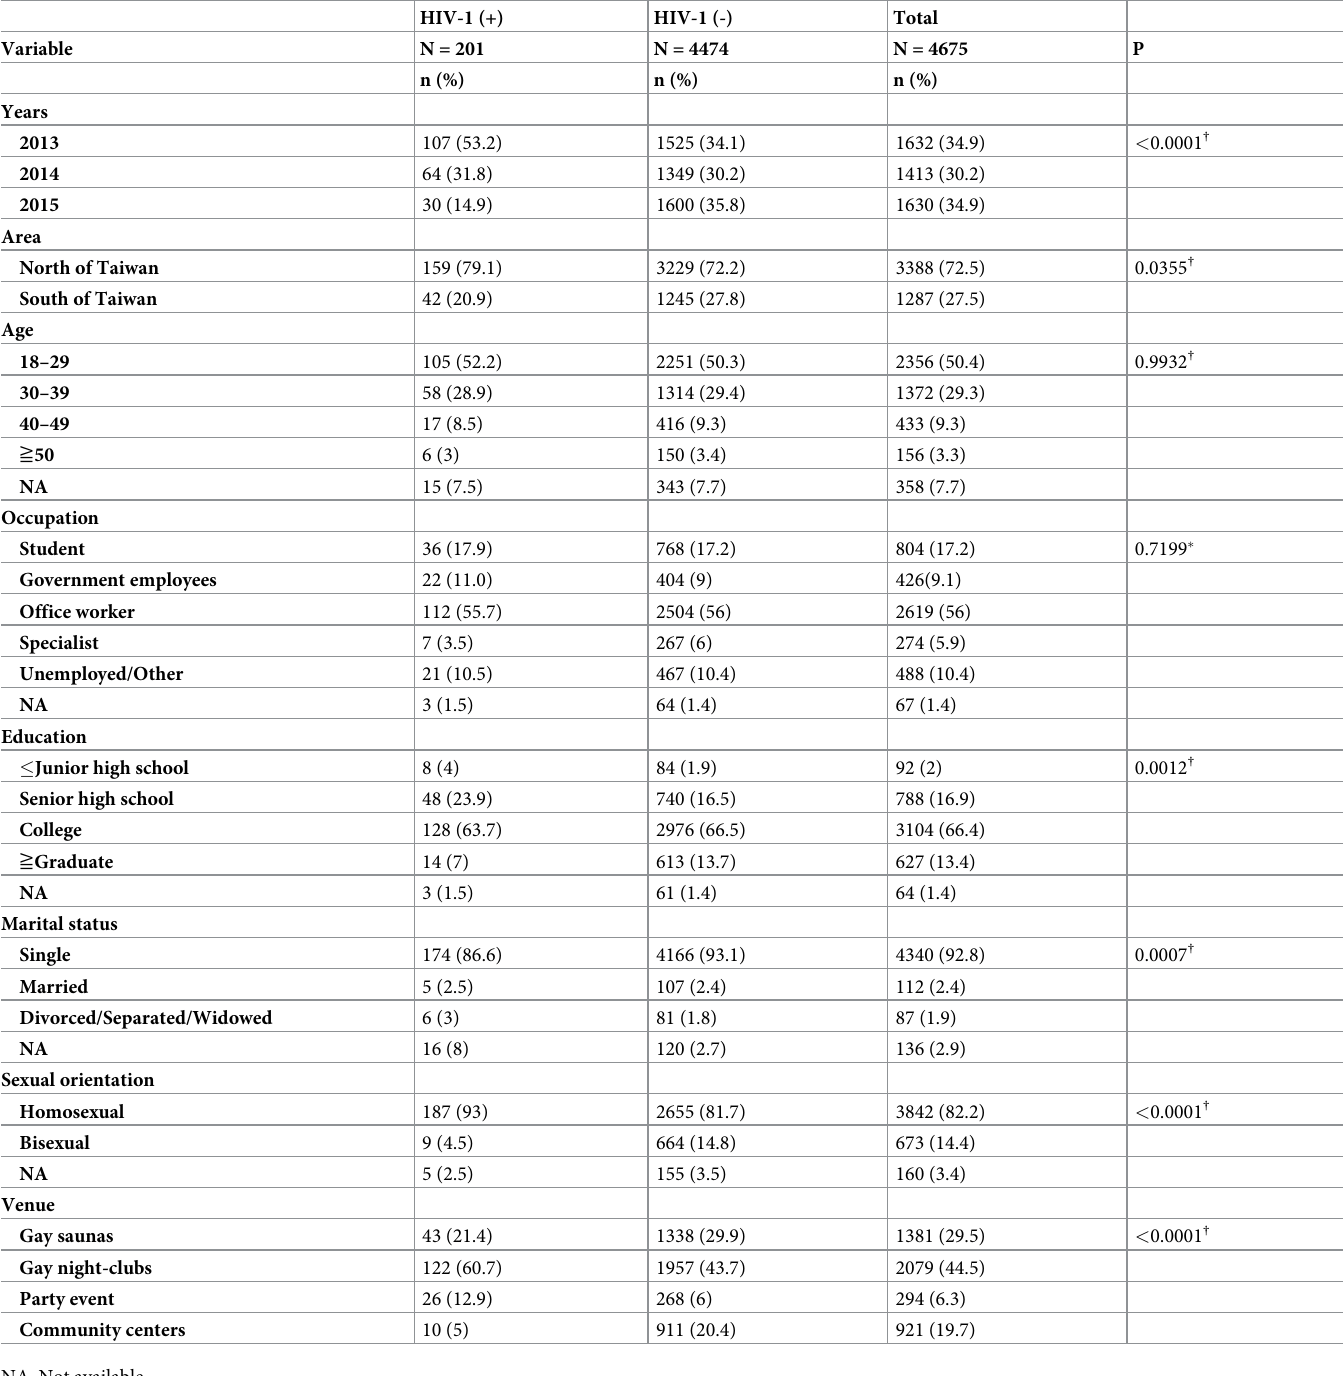
Table 1. Demographic data of patrons from different gay venues participated in this